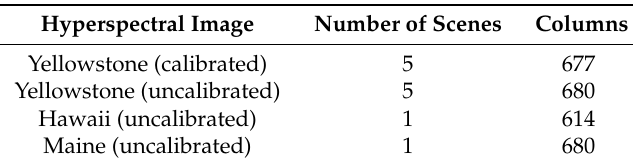
Table 2. Description of the Dataset